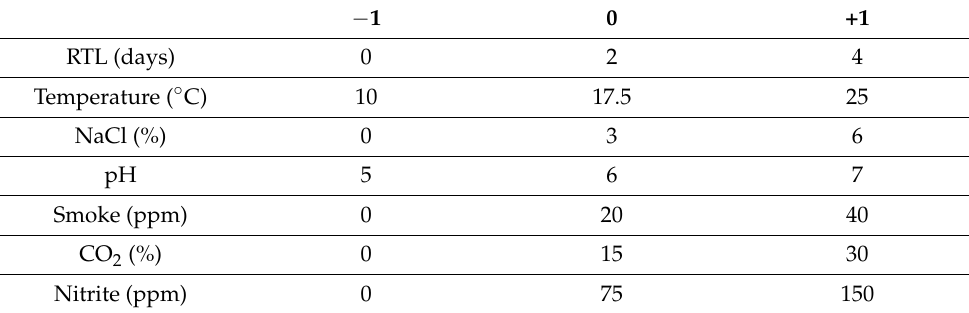
Table 1. Coded levels of the